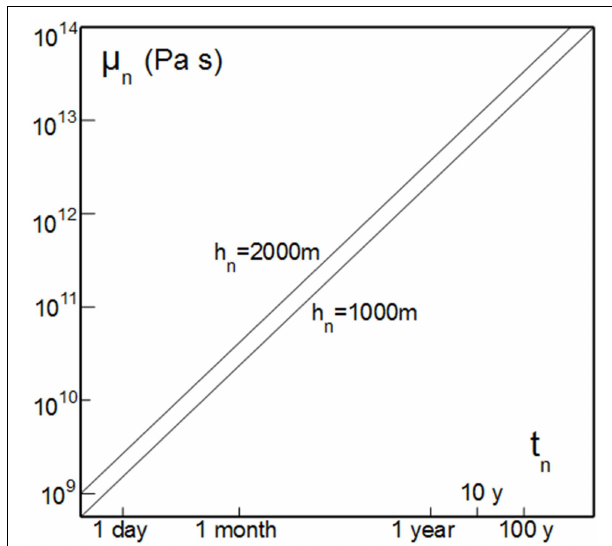
FIGURE 3 | The two lines of similarity for h n = 1000m and h n = 2000m show the range of natural viscosities versus natural times simulated by an experiment lasting 5h ( t = 18 . 000 s) with a cone 0.1m high (h m ). Both horizontal and vertical axes have log scales. The constant b and 38,888 for h n 1000 and 2000m, respectively ( µ m = ρ * 0 . 5 ). Explanation in the =